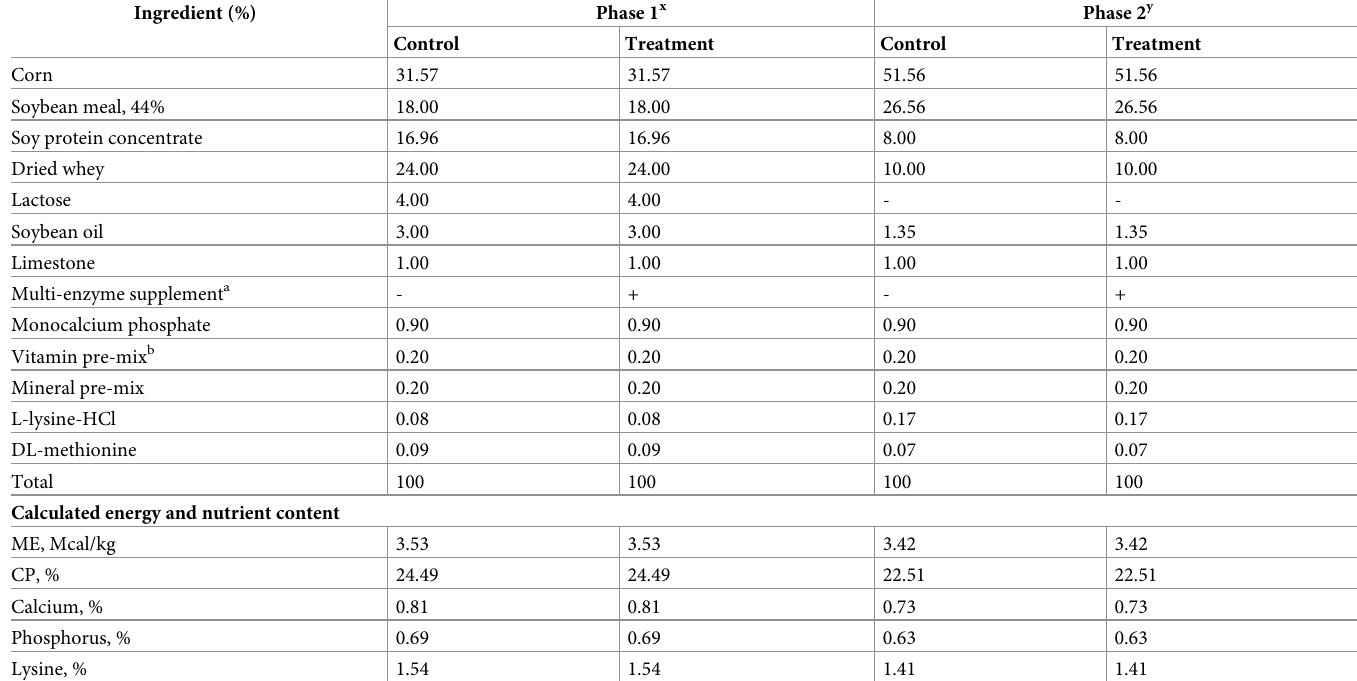
Table 1. Composition of experimental diets fed for weaned